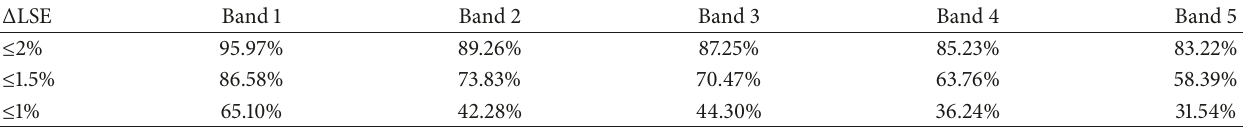
Table 3: The detailed statistical information of LSEs at each of the 5